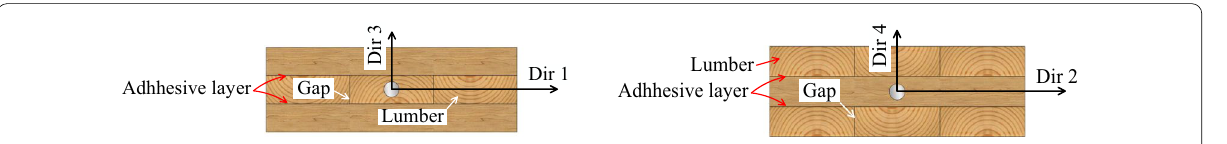
Fig. 2 Smooth dowel inserted in CLT narrow